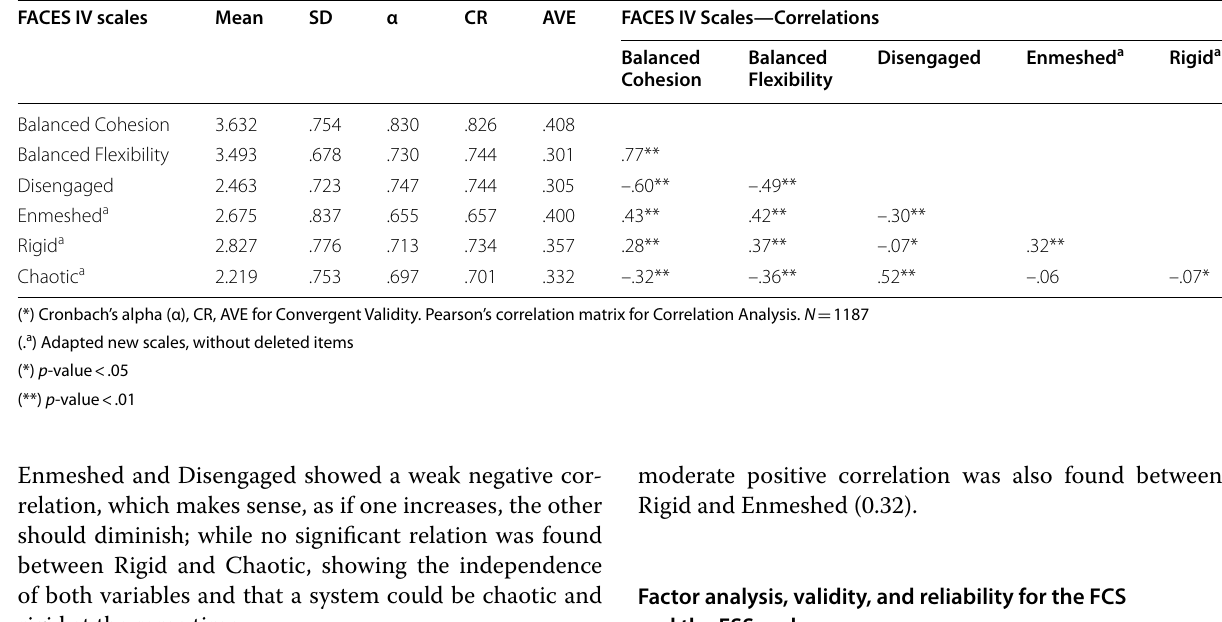
Table 3 Descriptive statistics (average scores), convergent validity, and correlation analysis for the new six FACES